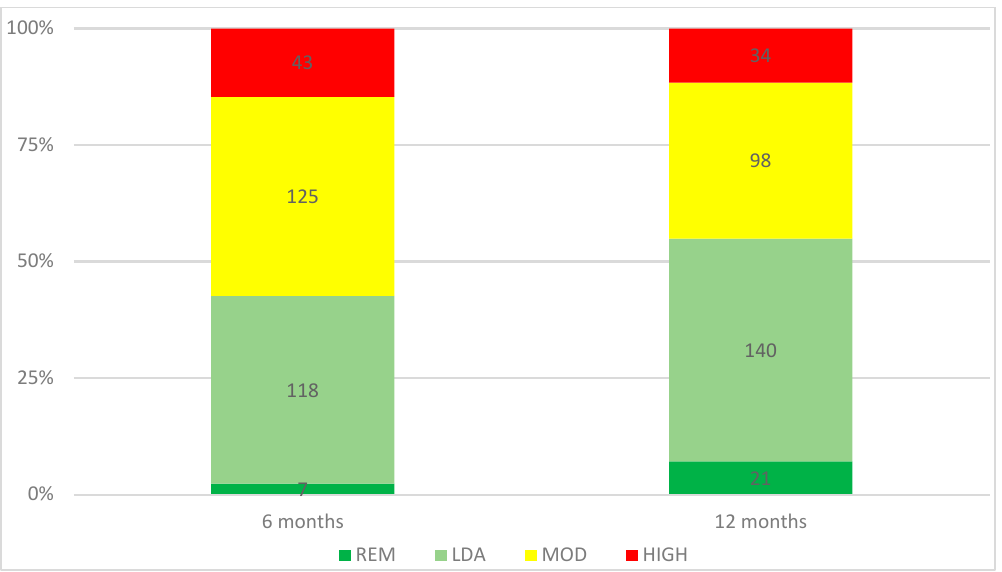
Figure 2. DAPSA scores at 6 and 12 months. REM remission, LDA low disease activity, MOD moderate disease activity, HIGH high disease activity.